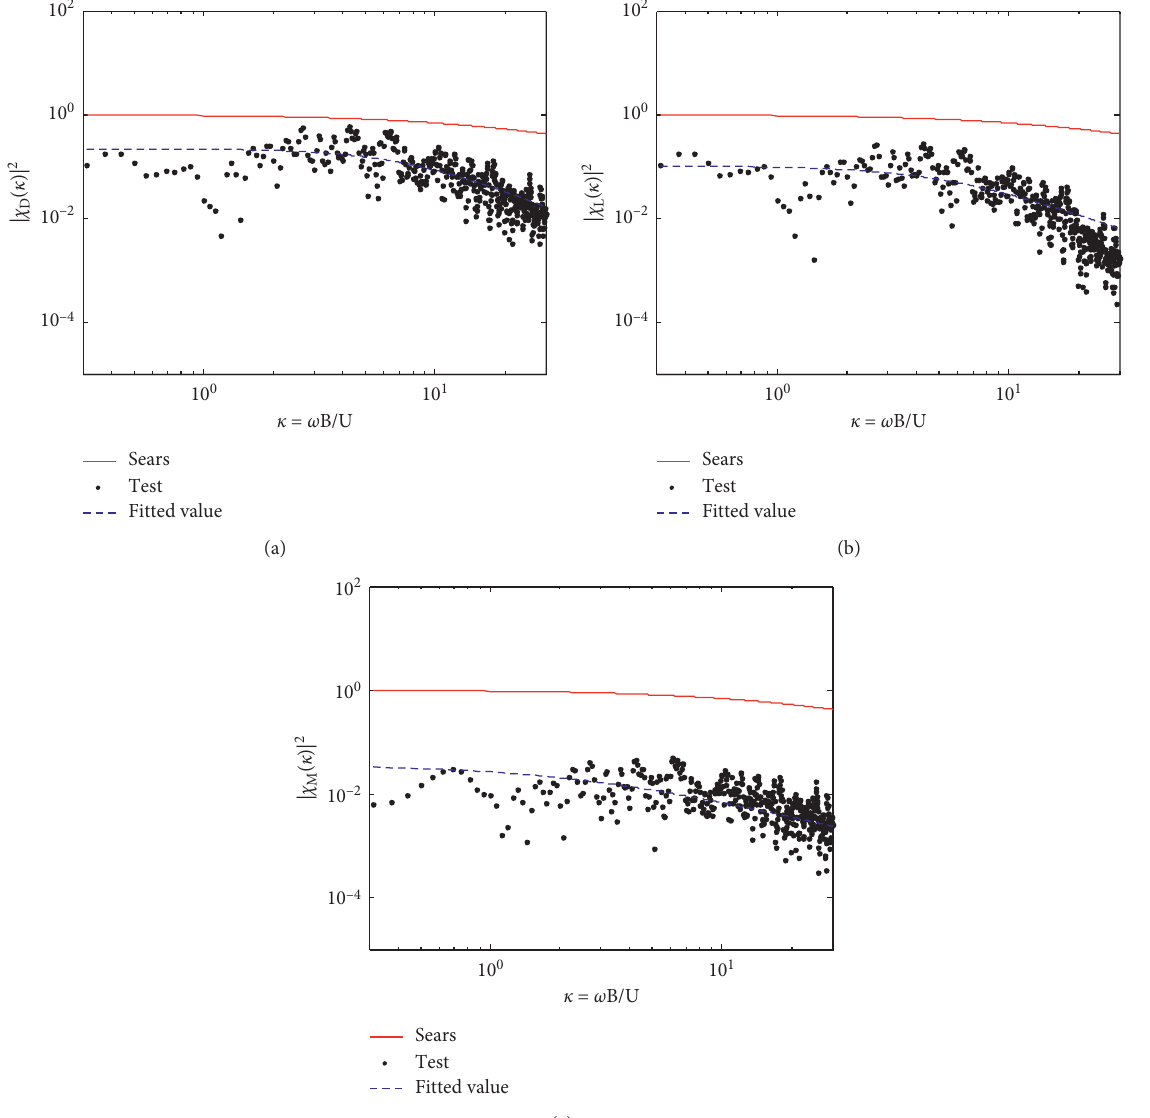
2 , (b) | χ 2 , and D | L |